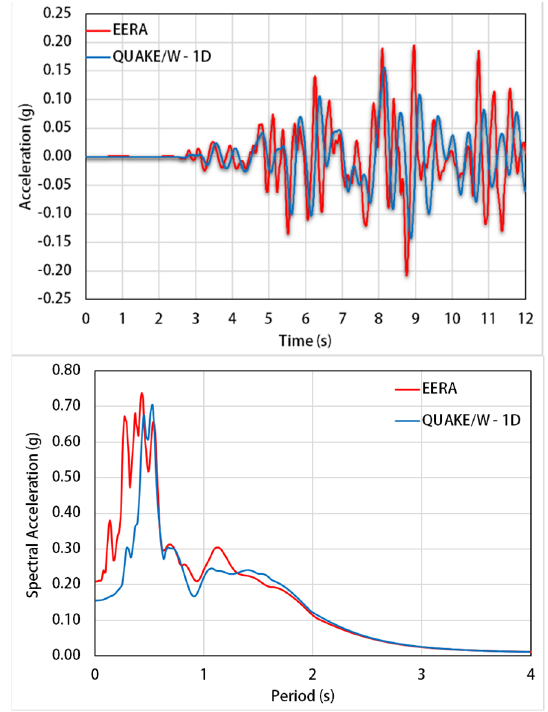
Figure 14. Comparison between 1-D analyses performed by EERA and QUAKE/W for point 2, in terms of acceleration time history and spectral acceleration, for the Amoruso et al. [26] input.